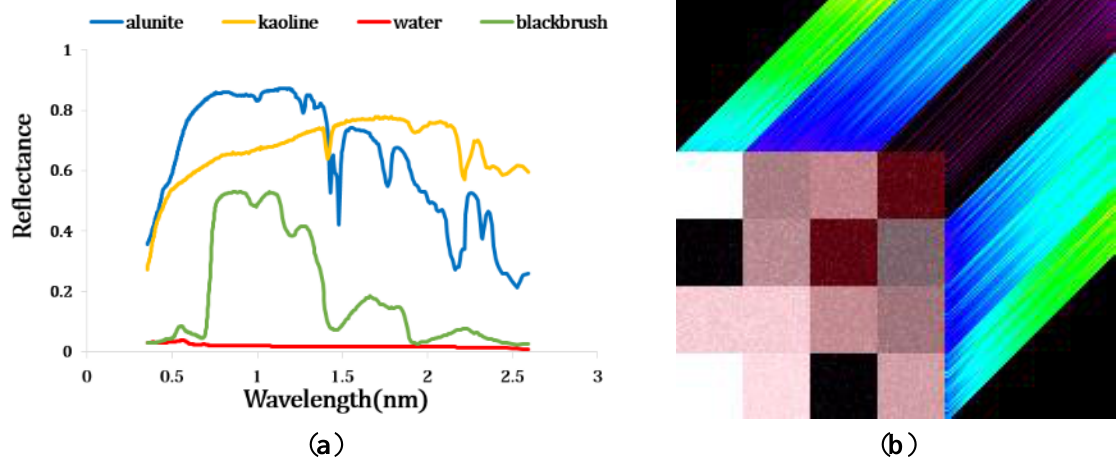
Figure 3. ( a ) Spectra of four materials obtained from USGS spectral library. ( b ) Synthetic hyperspectral image with SNR 30